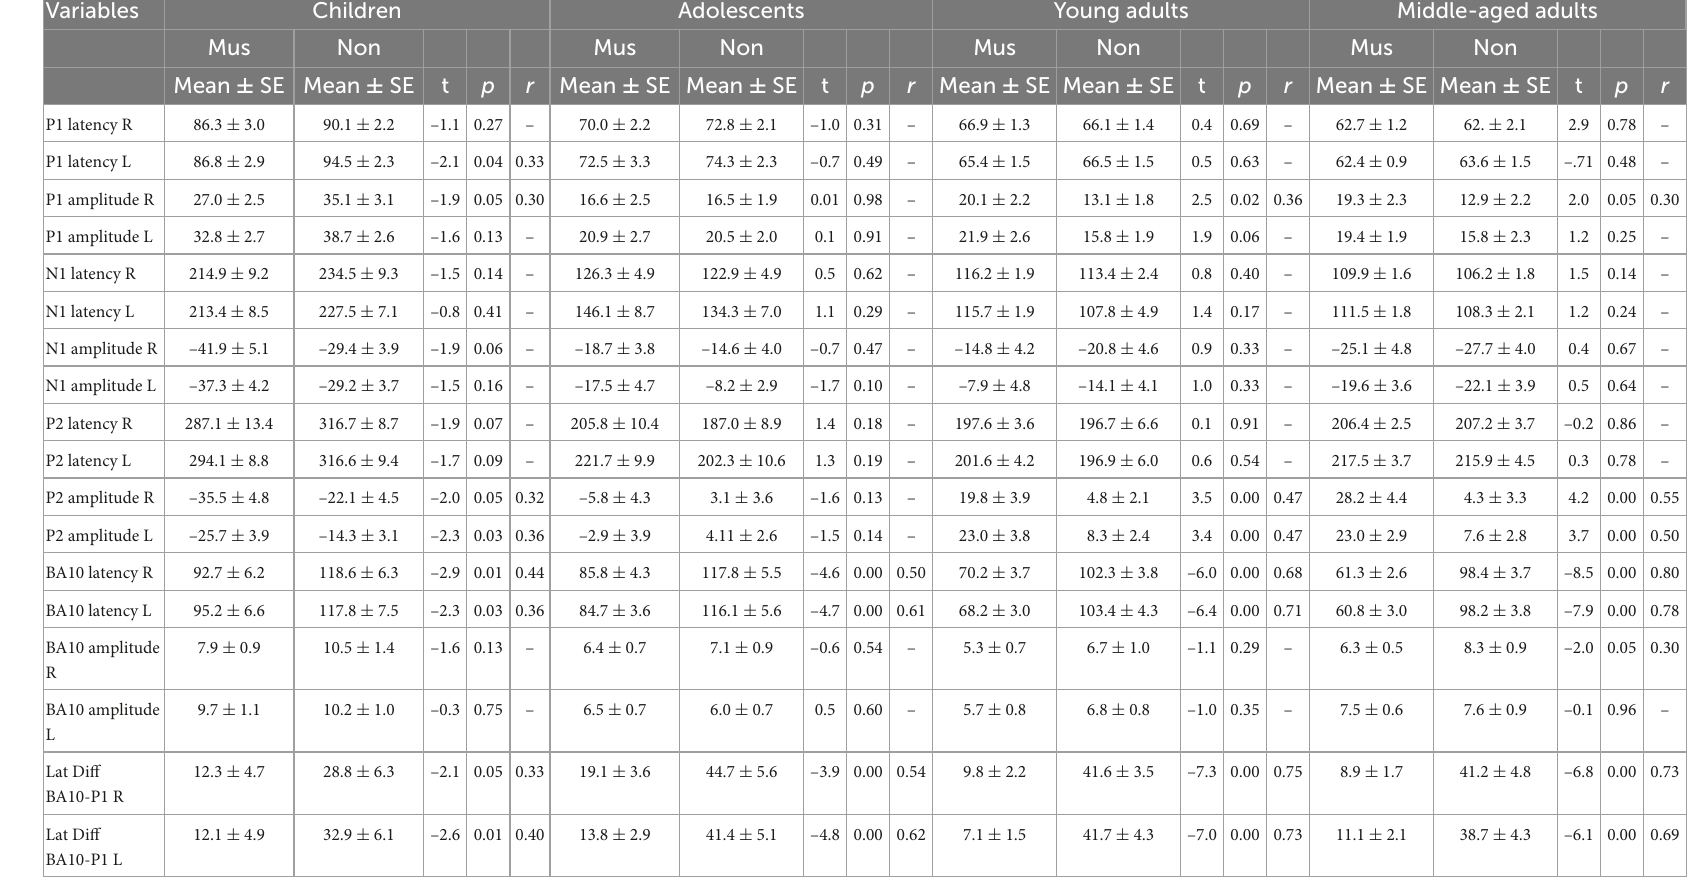
TABLE 3 Independent t -test (musicians vs.